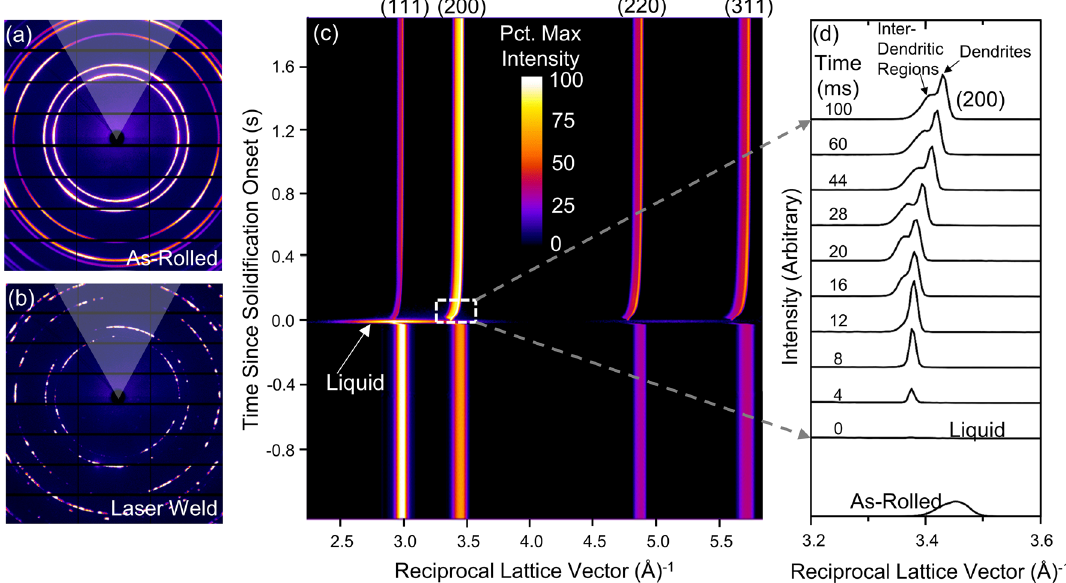
Figure 3. In situ synchrotron x-ray diffraction data: ( a , b ) Raw detector images resulting from ex situ 100 ms beam exposures on ( a ) rolled material before the laser scan and ( b ) fully cooled, re-solidified material after the laser scan. White overlays in ( a-b ) represent the azimuthal range for diffraction pattern integration. ( c ) Visual representation of the in situ evolution of XRD patterns before and after the onset of solidification. Brightness corresponds to normalized diffracted intensity as shown by the color scale. ( d ) Integrated (200) diffraction peak at selected time intervals following the onset of